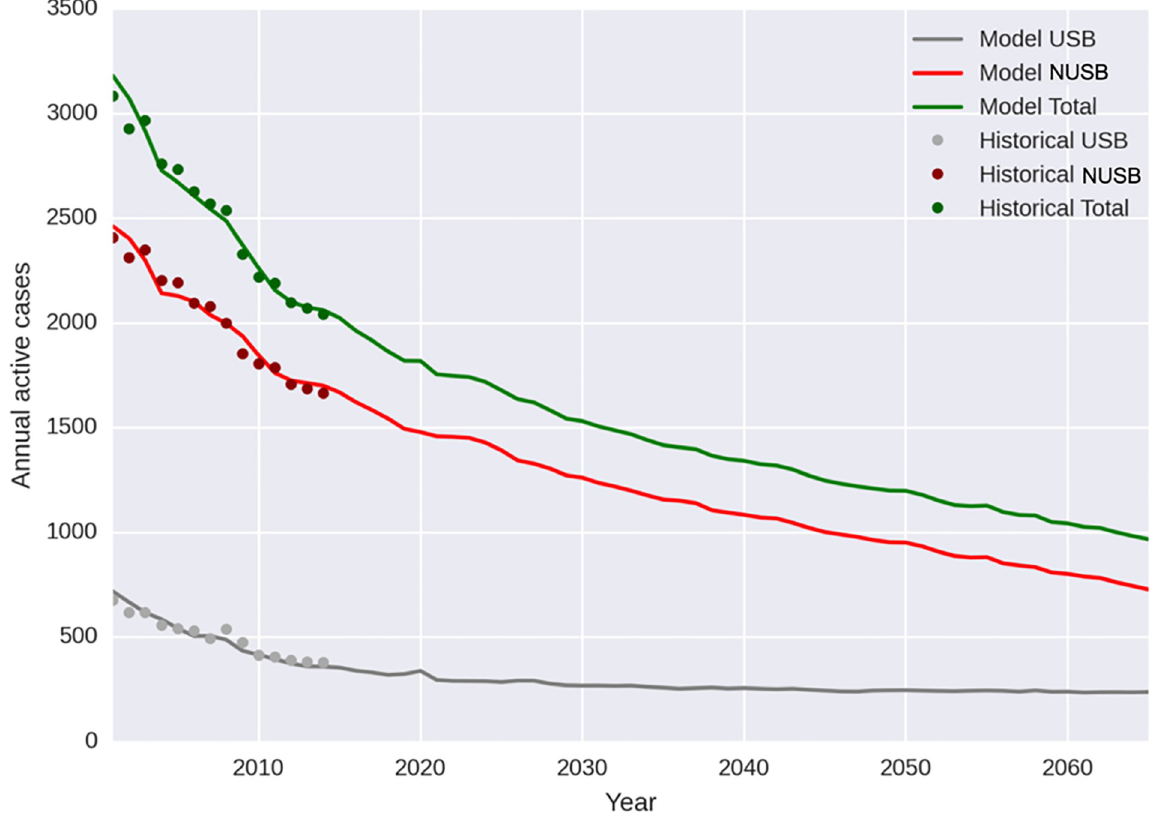
Fig 2. Results of calibration. Mean number of TB cases predicted by model (250 iterations) and historic TB case data reported to California Department of Public Health, in the US-born (USB) and non-USB (NUSB), 2001–2014. For uncertainty ranges in modeled predictions, see Fig